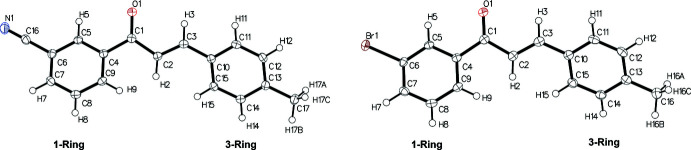
The asymmetric units of m′CNpCH3 (left) and m′BrpCH3 (right) showing the atom labeling with displacement ellipsoids drawn at the 50% probability level.